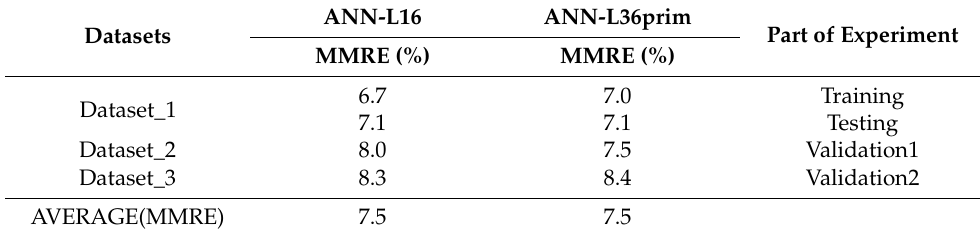
Figure 8. “Winner“ MRE vs. MMRE on the training dataset (ANN-L36prim). Figure 8. “Winner” MRE vs. MMRE on the training dataset (ANN-L36prim). The obtained results for the two proposed architectures, ANN-L16 and ANN-L36, in all three parts of the experiment showed that the different nature of the data set does not affect the complexity of the architecture used. That is, it does not depend on the value of the input values. In the first proposed architecture, ANN-L16, all six input values were used (where four are linearly independent and two linearly dependent), and the MMRE value in all three parts of the experiment is 7.5% of Table 7. Using the second architecture, ANN-L36prim, with four independent input values, the same MMRE value, of 7.5%, was obtained in all three parts of the experiment (Table 7). The error differences in individual parts of the experiment are not more than 0.5%, indicating the proposed model’s reliability. Table 7. MMRE value in all three parts of the experiment (UCP).